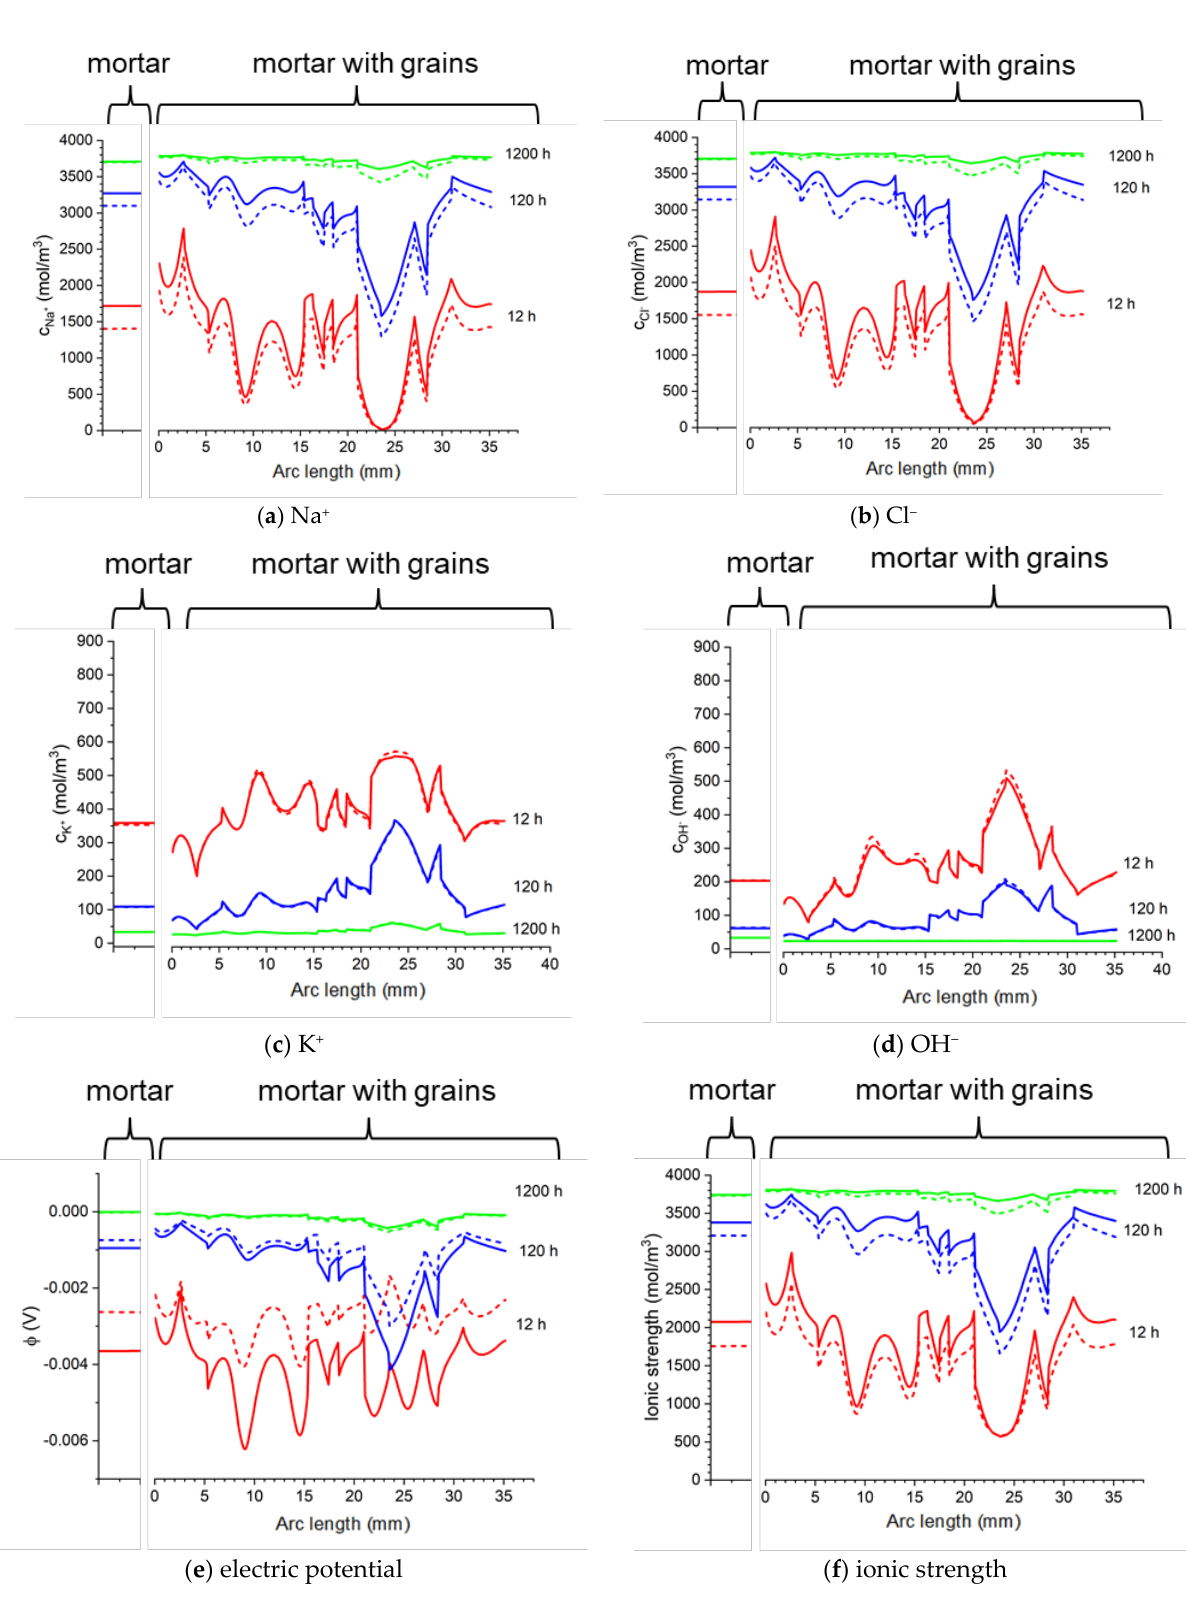
Figure 24. Calculated: ion concentrations: ( a ) Na + , ( b ) Cl − , ( c ) K + , ( d ) OH − , ( e ) potential ( φ ), and ( f ) ionic strength in the mortar and concrete samples at the distance 13 mm from the center of the sample in the sample in 20% NaCl water solution (along a blue line). Solid lines correspond to the solution for the Pitzer activity model and dashed lines are the solution neglecting activities ( γ = 1 ) Figure 25 shows the concentrations of sodium, chloride, potassium, and hydroxide ions on the surface of the rod in the concrete sample (along the line in Figure 23d) and in the mortar (along the line in Figure 23c) after different process times of sample immersion in 20% NaCl water solution. The solid lines show the calculations for the Pitzer activity model, and the dashed line is the solution for an ideal solution approximation ( γ =1). Ion concentrations on the surface of the rod for the mortar sample are constant (“ mortar ” parts in Figure 25), which result from the symmetry of the system and differ in value in relation to concrete samples. Inhomogeneous distr ibution of ion concentrations in concrete (“ mor- tar with aggregates ” parts in Figure 25), in particular chloride ions, when Cl − threshold con- centration is reached may result in a local break in the passive oxide layer and consequen- tial development of nonuniform corrosion of the rod in concrete. A similar trend is observed for dilute solutions and calculations for a 5% NaCl water solution are shown in Supplementary Material 3.